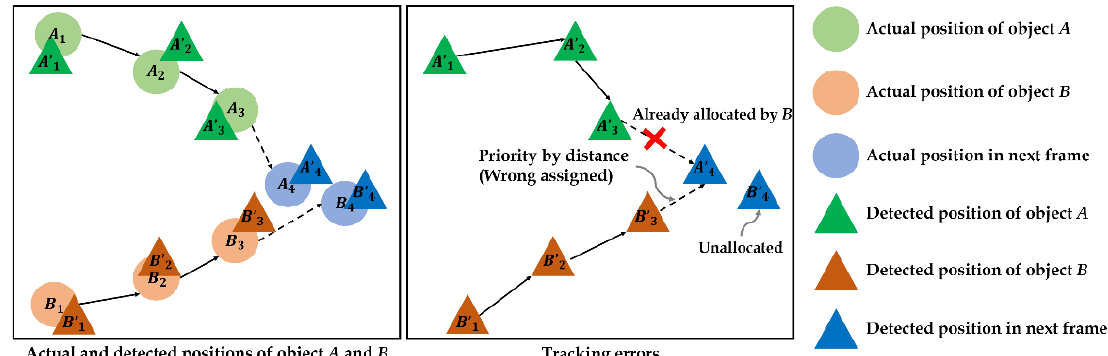
Figure 4. Example of the actual movements of two objects ( left ); and tracking errors ( right ).